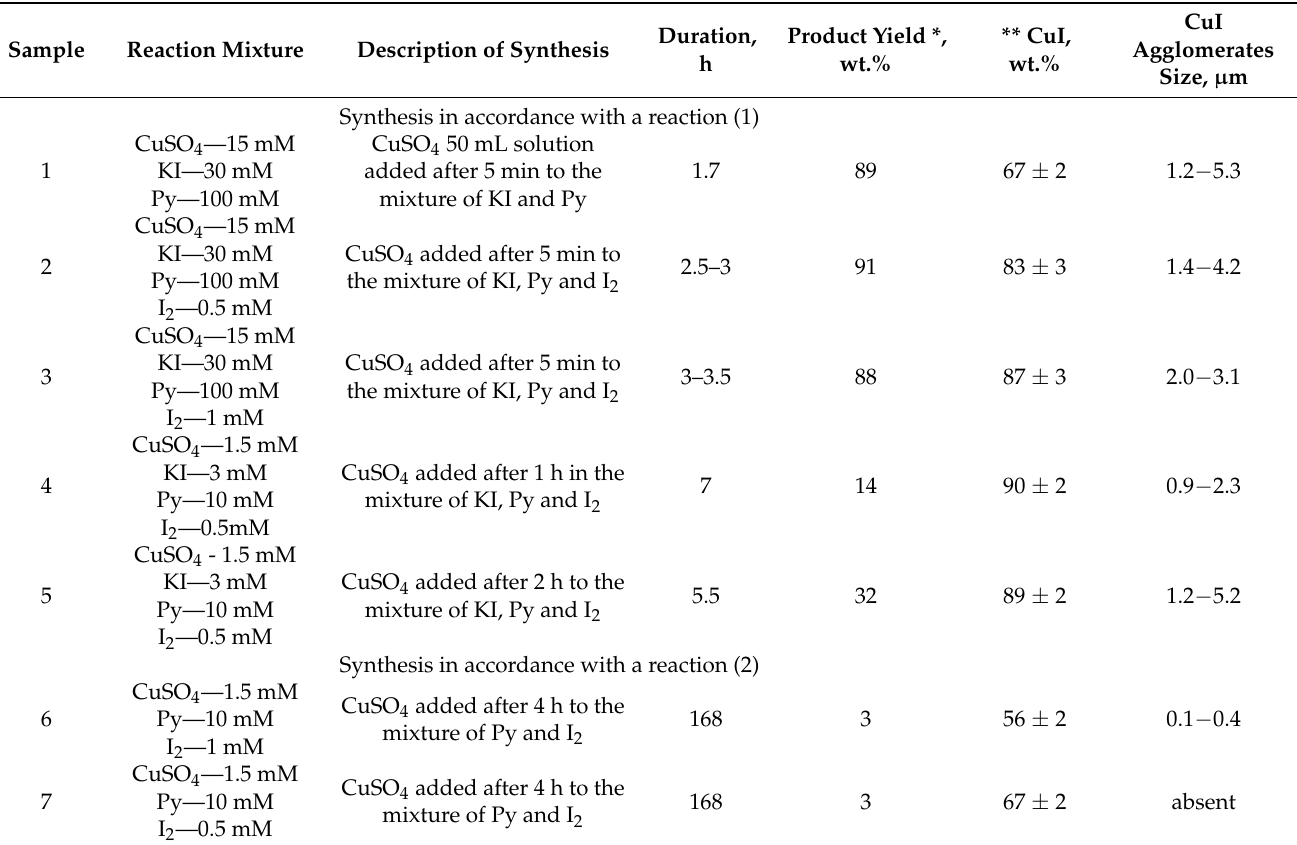
Table 1. The impact of experimental conditions on the product yield and copper iodide (CuI) content in the hybrid